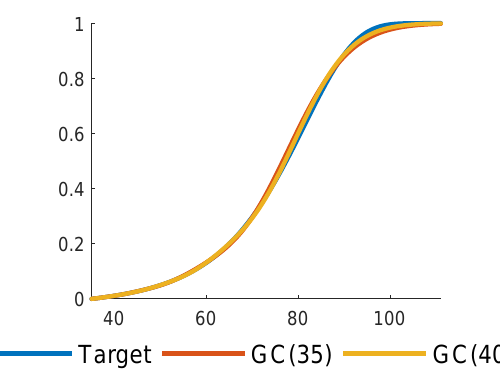
Figure 5. Tails of the life table and GC fits with p = 35,40 phases.